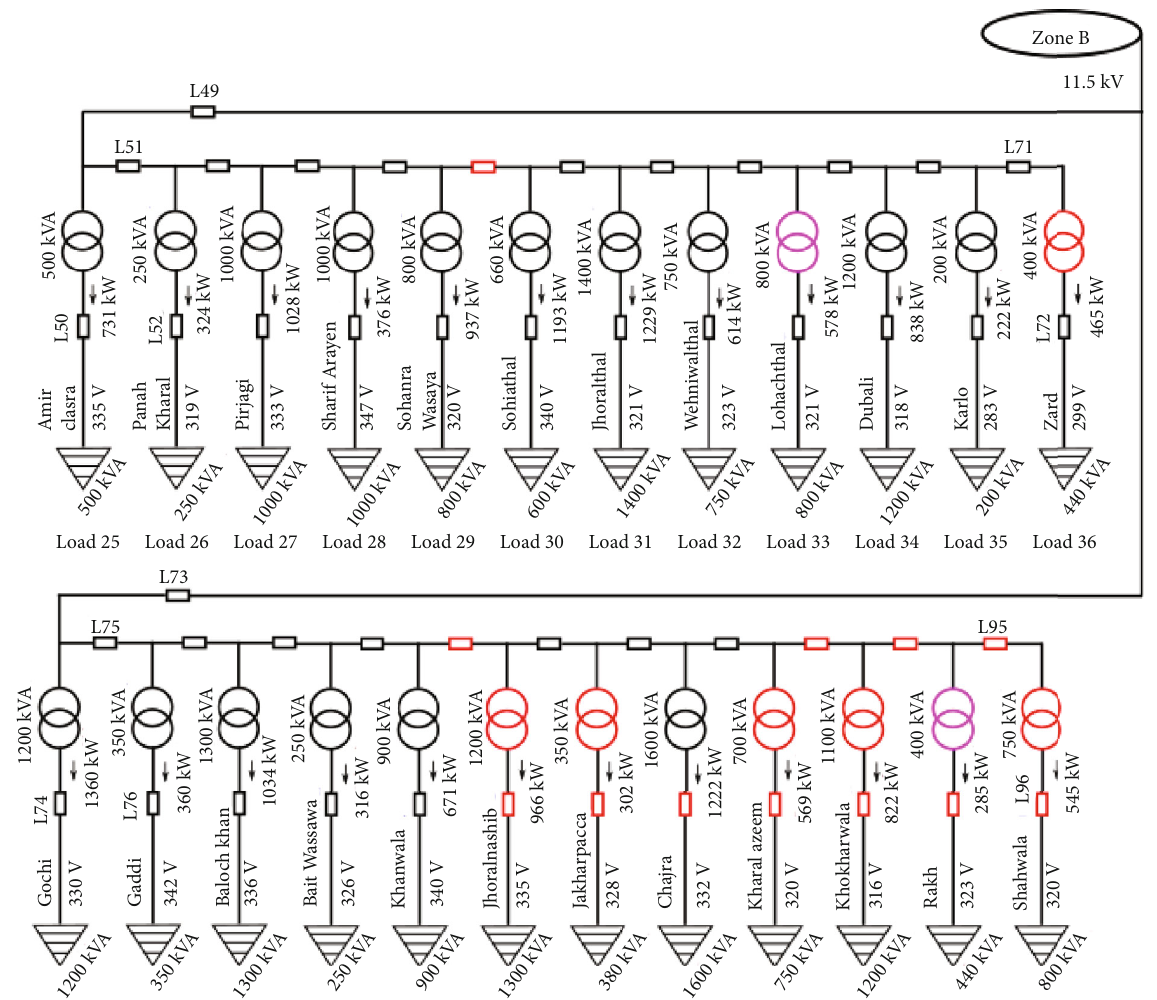
Figure 9: Implementation of zone B of the existing system on